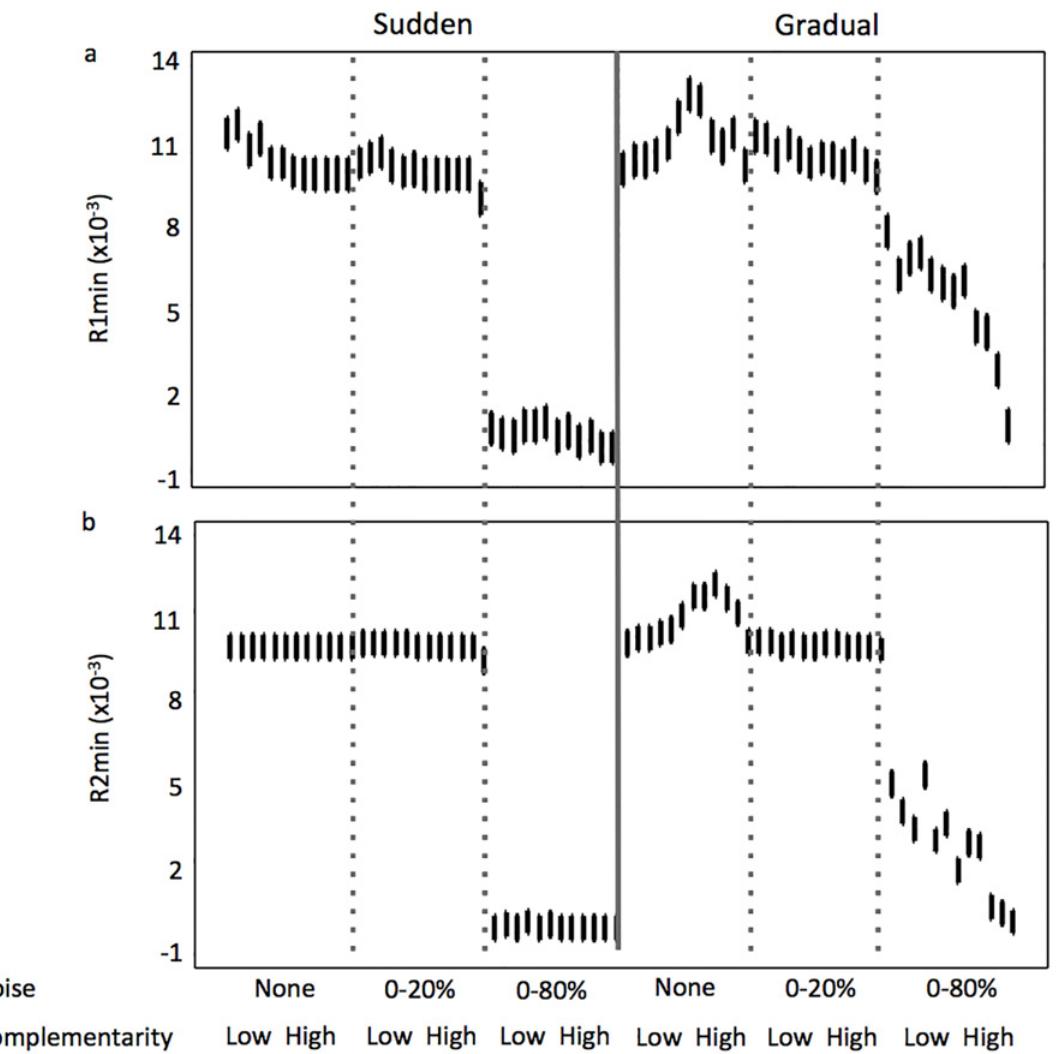
Fig 9. Variability of minimum in Recourse 1 (a) and Resource 2 (b) along a gradient of increasing complementarity in the assemblages and noise in resource concentration from the supply, when the reversal in resource supply concentrations is sudden and gradual. Error bars represent 95% confidence